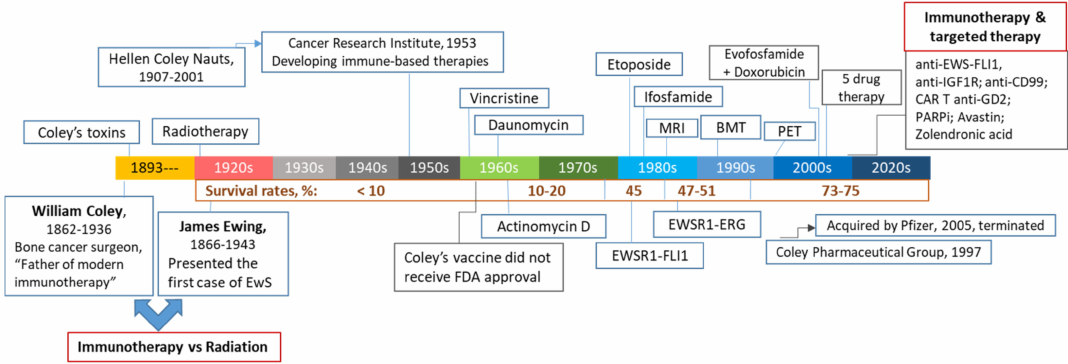
Figure 1. The 100-year-old battlefield between immunotherapy and radiotherapy in treating patients with bone and soft-tissues sarcomas. Milestones and major events are documented in a chronological